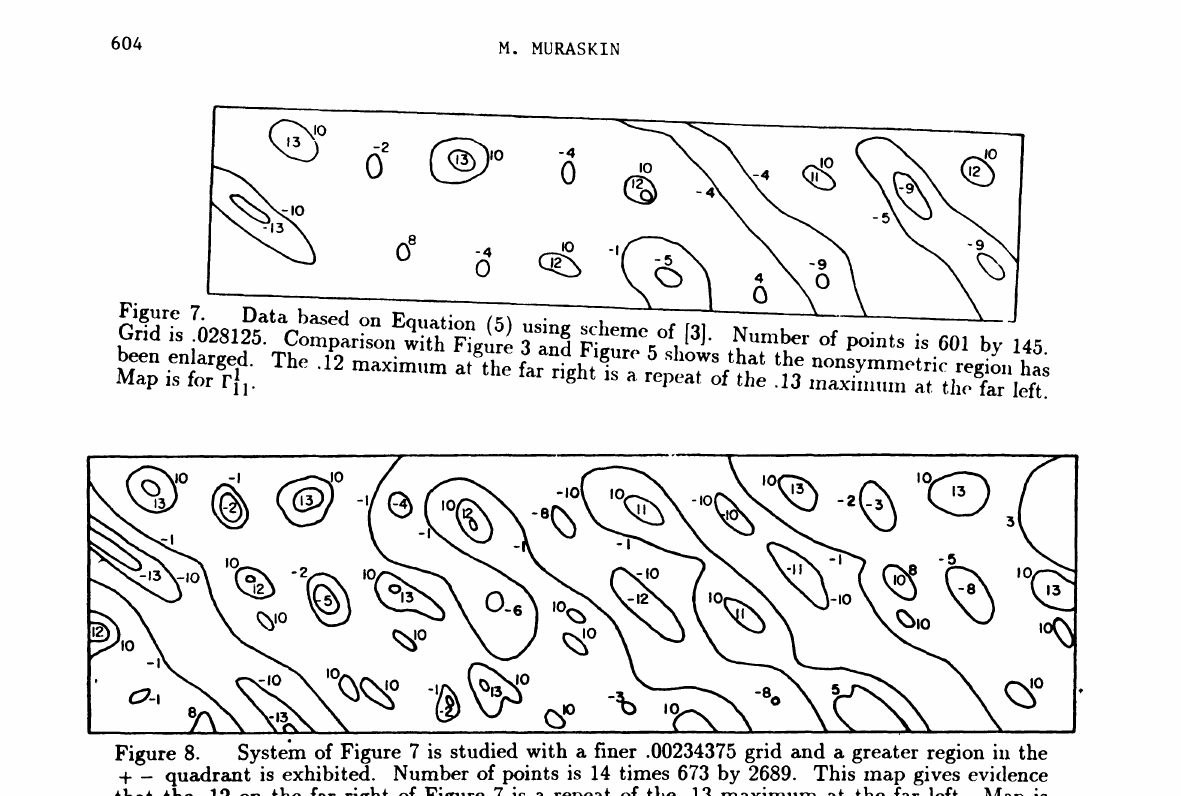
Number of points is 601 by 145. that the nonsymmetric region has is a repeat of the .13 znaximum at the far left. I 13 io